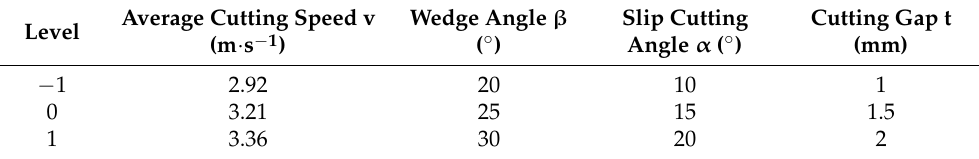
Table 3. Factors and Levels of the Supported Cutting Multi-Factor